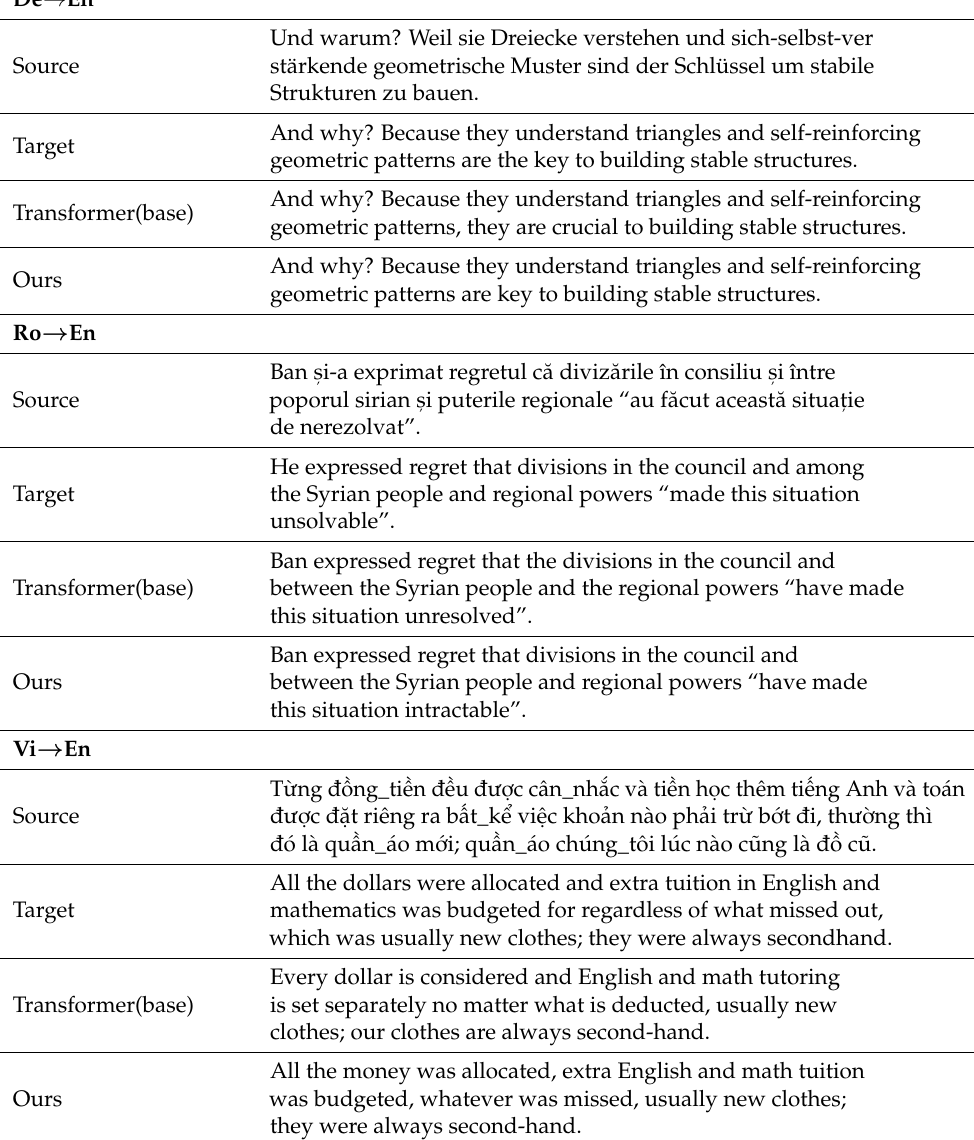
Table 4. Examples from Tranformer(base) and our approach on De → En, Ro → En, and Vi →